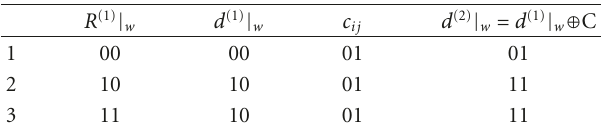
Table 2: Share construction procedure of (2,3)-VSS scheme